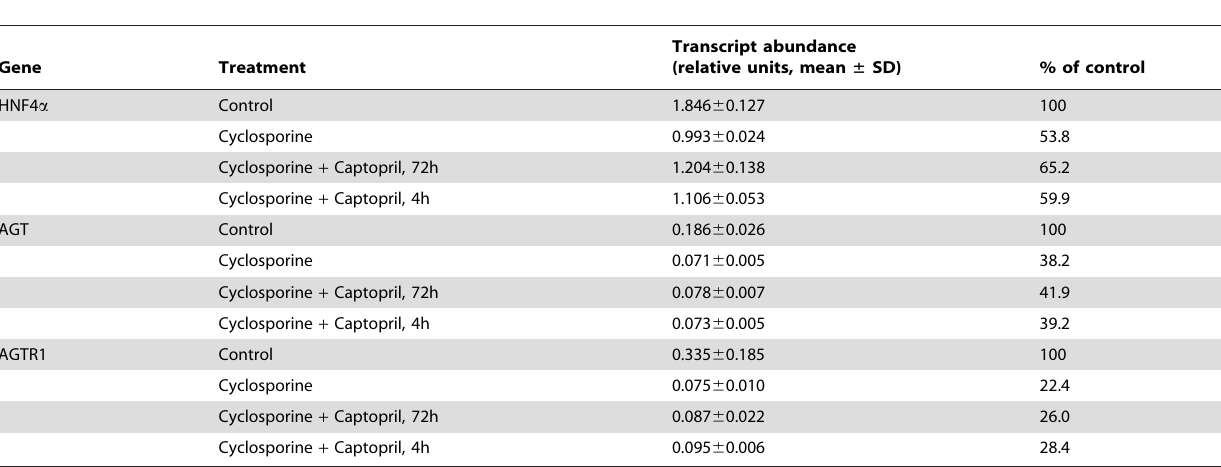
Table 3. Gene expression in HepG2 cells after treatment with